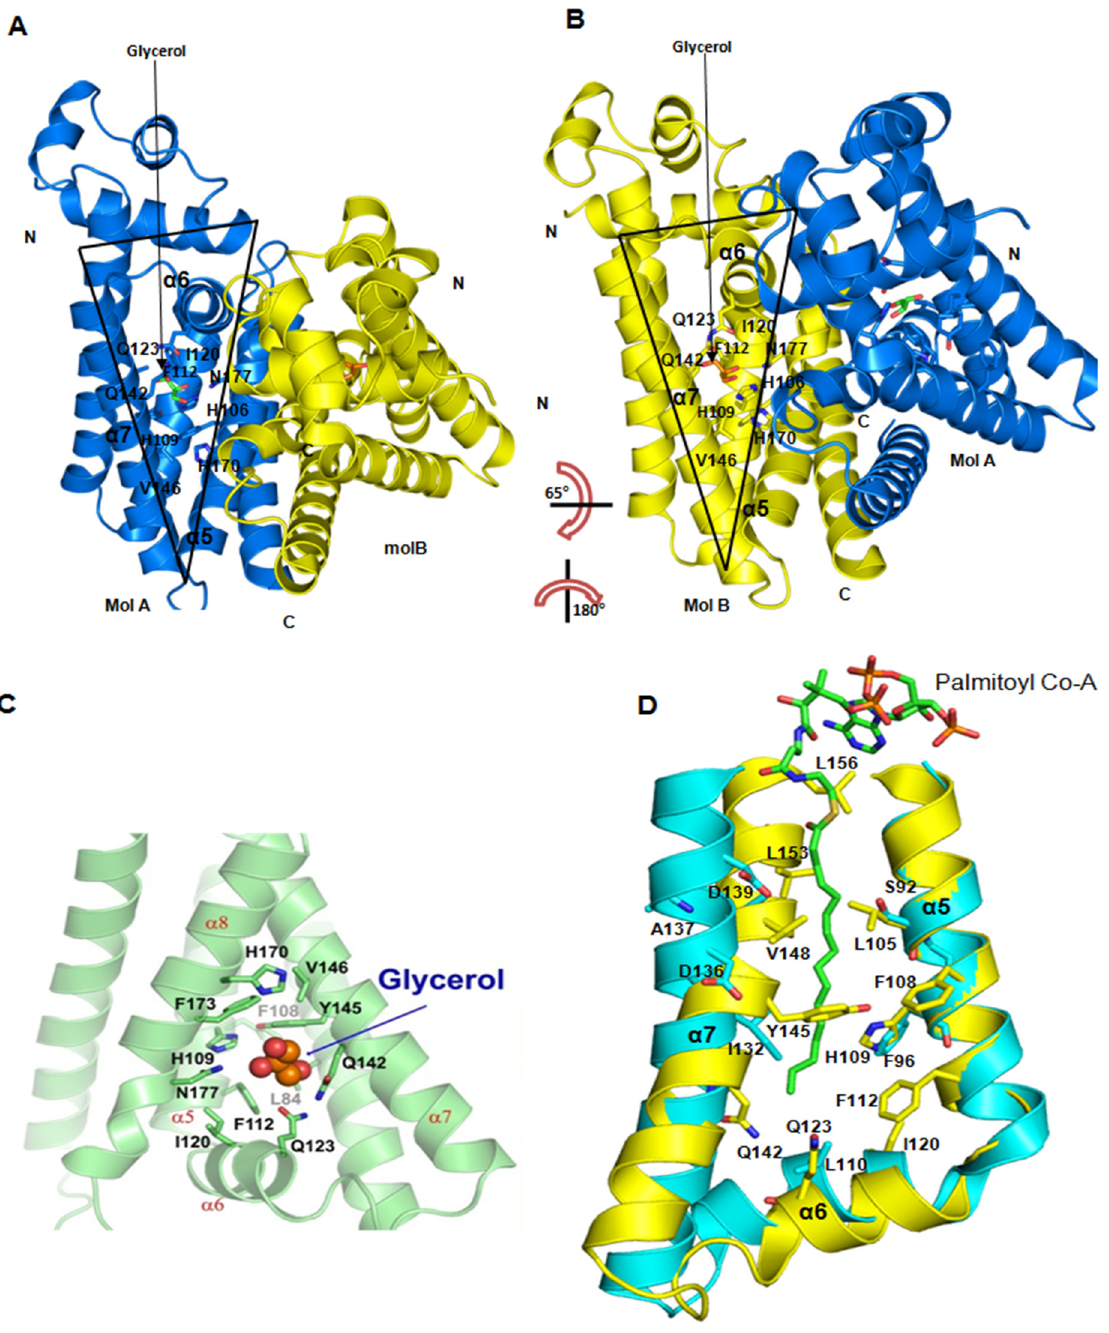
Fig 2. Structural view of ligand binding pocket. A & B) The open and opposite orientations of two triangular ligand binding cavities of two monomers (blue and yellow), superimposed by 180° rotation around vertical axis followed by 65° rotation of x-axis. C) The structural view of ligand binding pocket of one monomer. The glycerol is shown as space filling and predicted ligand binding residues are shown in sticks. D) View of Fad35R (yellow) ligand binding pocket superimposed to that of DesT (cyan) bound to palmitoyl Co-A (PCA) (shown as sticks, orange) indicate that fatty acid tail can fit well into the cavity and L140, I132, and S92 may form interactions with